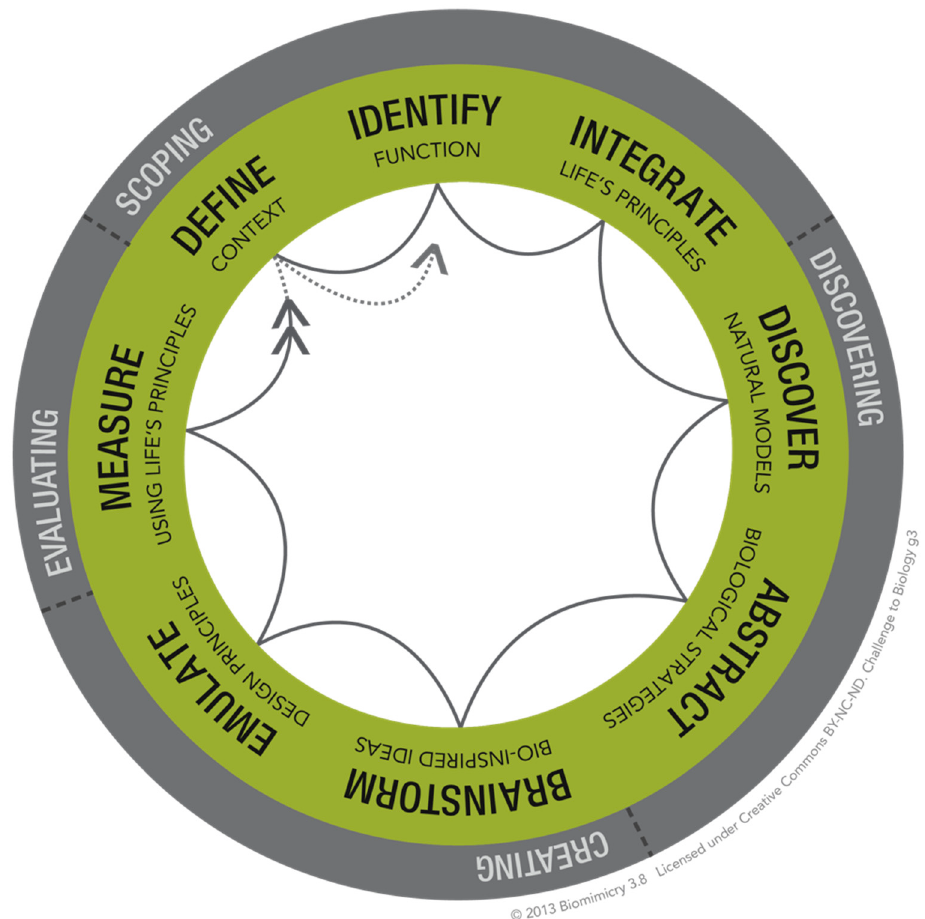
Figure 1. Biomimicry Thinking Design Lens Challenge to Biology ©2015 Biomimicry 3.8. CC BY- NC-ND. Permission granted by Biomimicry 3.8 under Creative Commons.